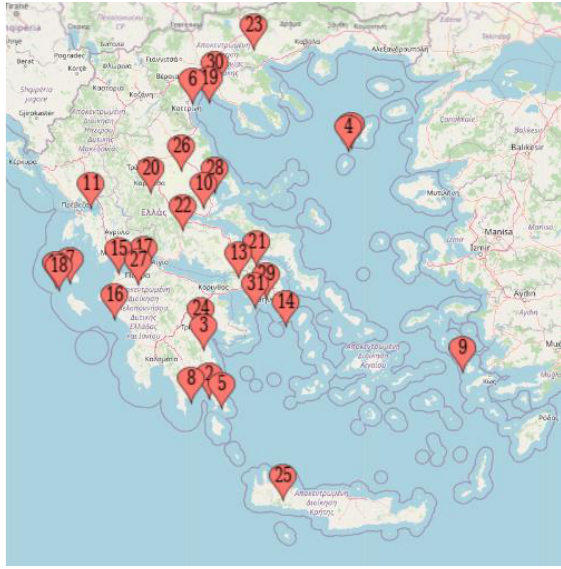
Figure 1. The location of the 31 WWTPs.